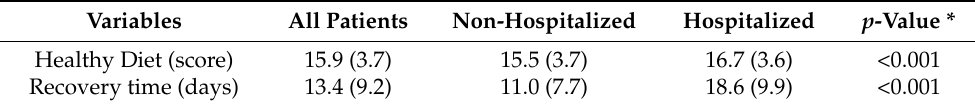
Table 2. Means and standard deviation (SD) for healthy diet score and recovery time (days). Variables